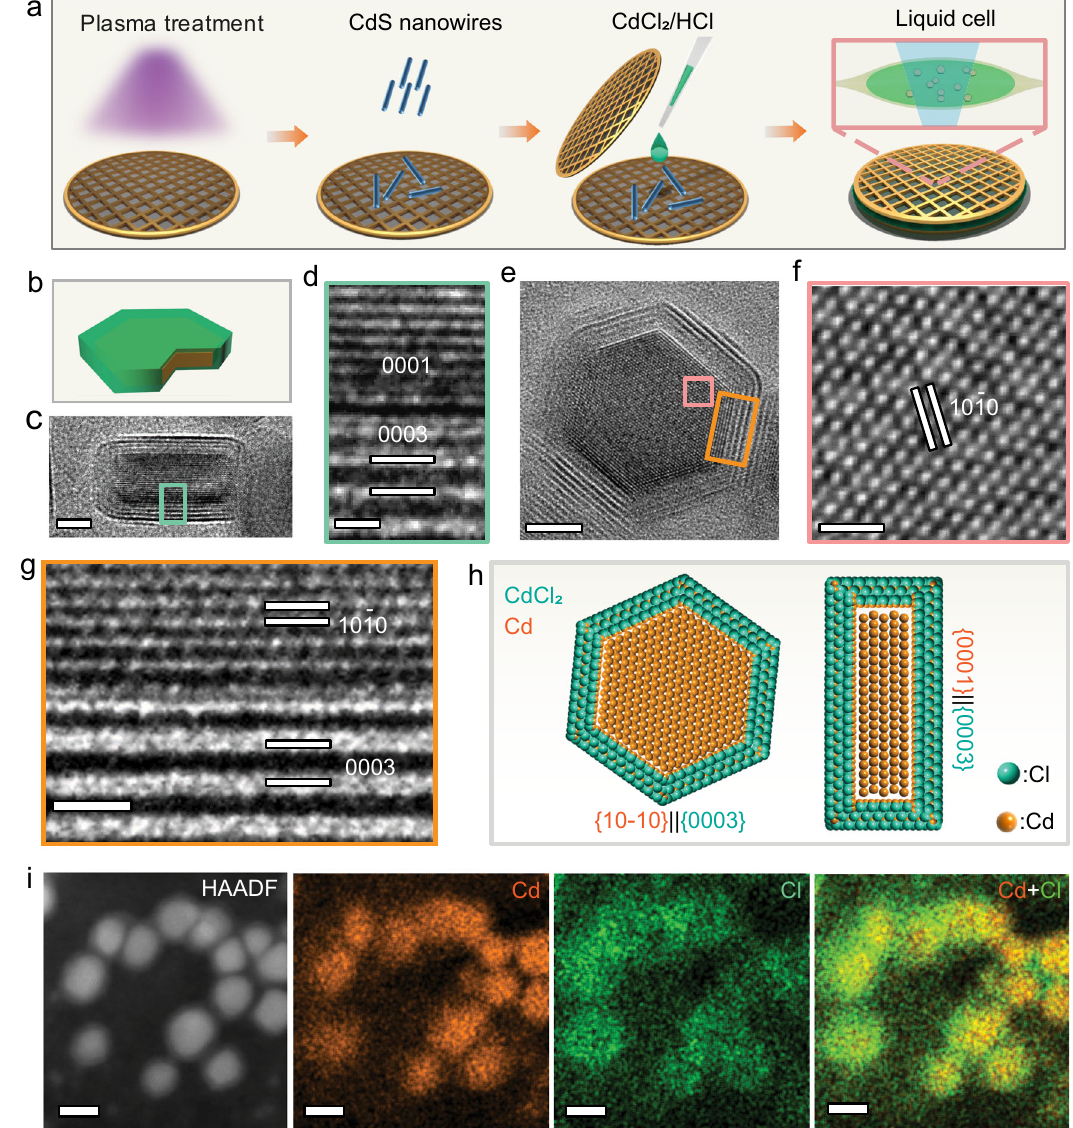
Fig. 1 Experimental setup and in-situ characterizations of Cd-CdCl 2 core-shell nanostructures. a A Schematic showing the preparation of a liquid cell and the formation of Cd-CdCl 2 core-shell nanoparticles. b A model of a core-shell nanoparticle indicating viewing directions for ( c ), ( e ). c TEM image from the side view. Scale bar, 5 nm. d HRTEM image from the selected area in ( c ) shows the interfacial structure. Scale bar, 1 nm. e TEM image from the top view. Scale bar, 5 nm. f , g HRTEM images from the selected areas in ( e ) showing the structures of the core and interface, respectively. Scale bar, 1 nm. h The schematic atom models of the core-shell structure showing the planar view and side view of the nanostructure with the epitaxial relationship, [(10 (cid:1) 10)Cd// (0003)CdCl 2 ] and [(0001)Cd//(0003)CdCl 2 ]. The Cd atoms are orange and Cl atoms are green in the atom models. i High-angle annular dark- fi